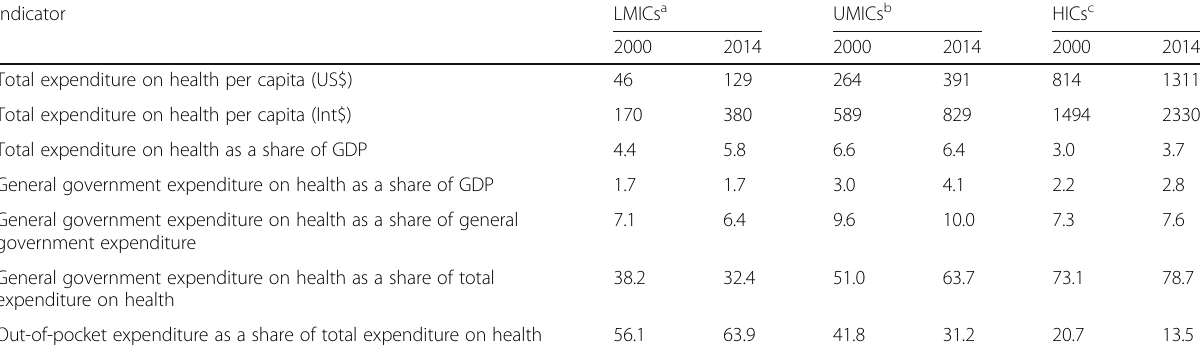
Table 3 Mean health financing indicator values for the Middle East and North Africa Region by World Bank income group, 2000 – 2014